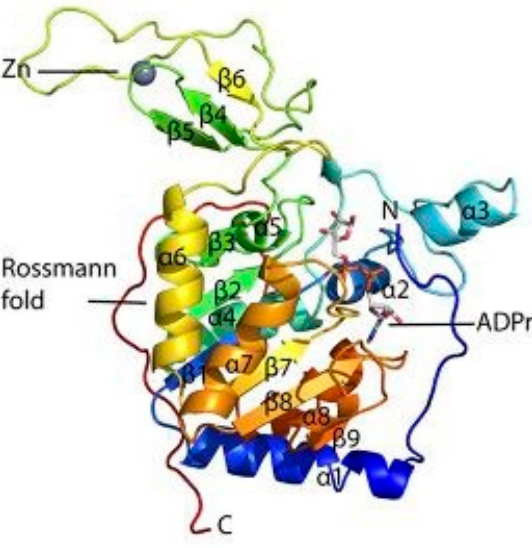
Figure 1. Structure of a SIRT6 monomer (adapted from reference [21]).